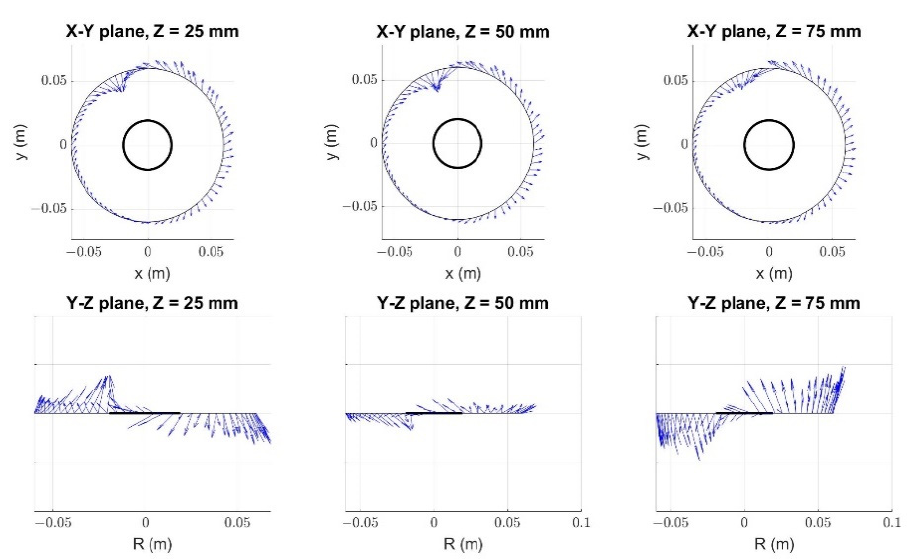
Figure 7. Stray magnetic field orientation in 3 horizontal planes, for the difference vector ( b ref ) between both rotation directions.